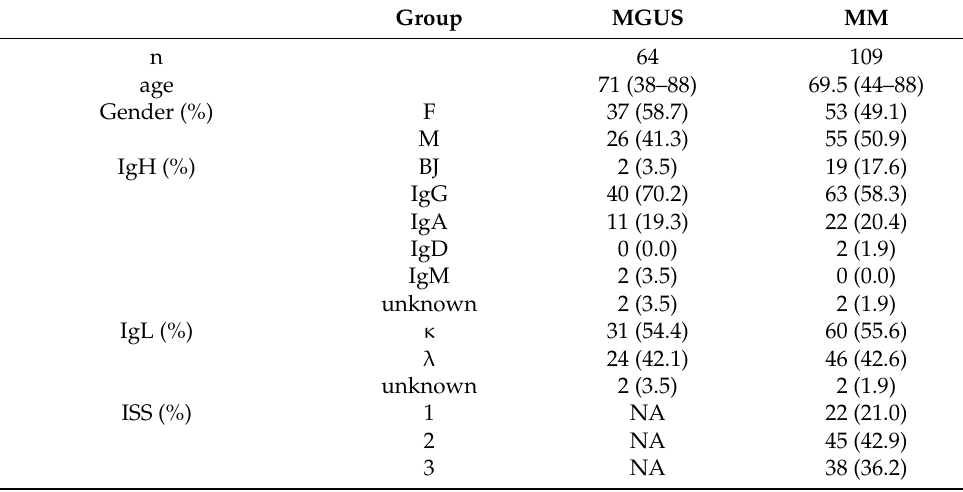
Table 1. Patients’ demographics. F: Female; M: Male; NP: not